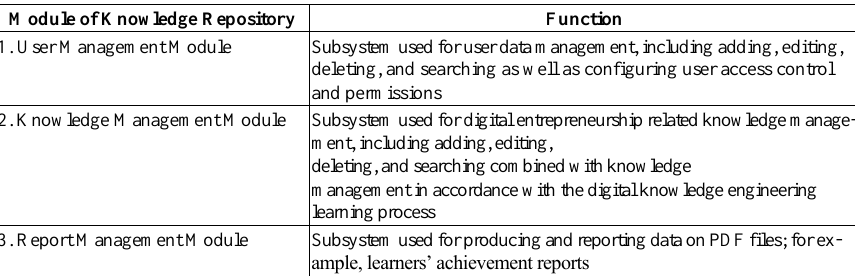
Table 7. Knowledge Repository Module